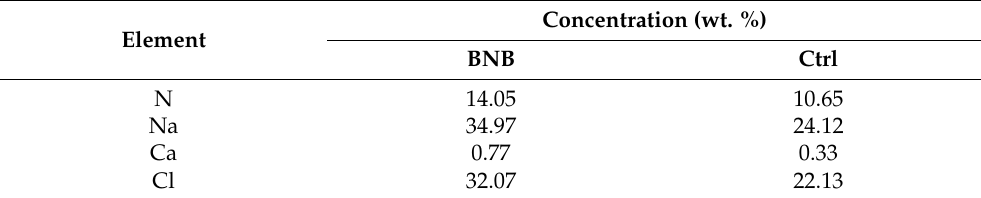
Concentration (wt.